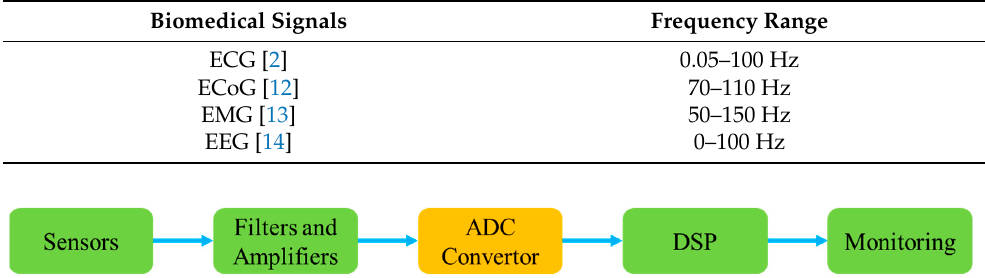
Figure 1. Block diagram of biomedical implantable device.